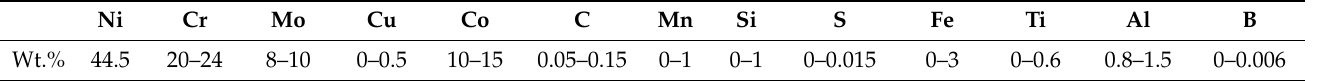
Table 1. Nominal chemical composition of Inconel 617.